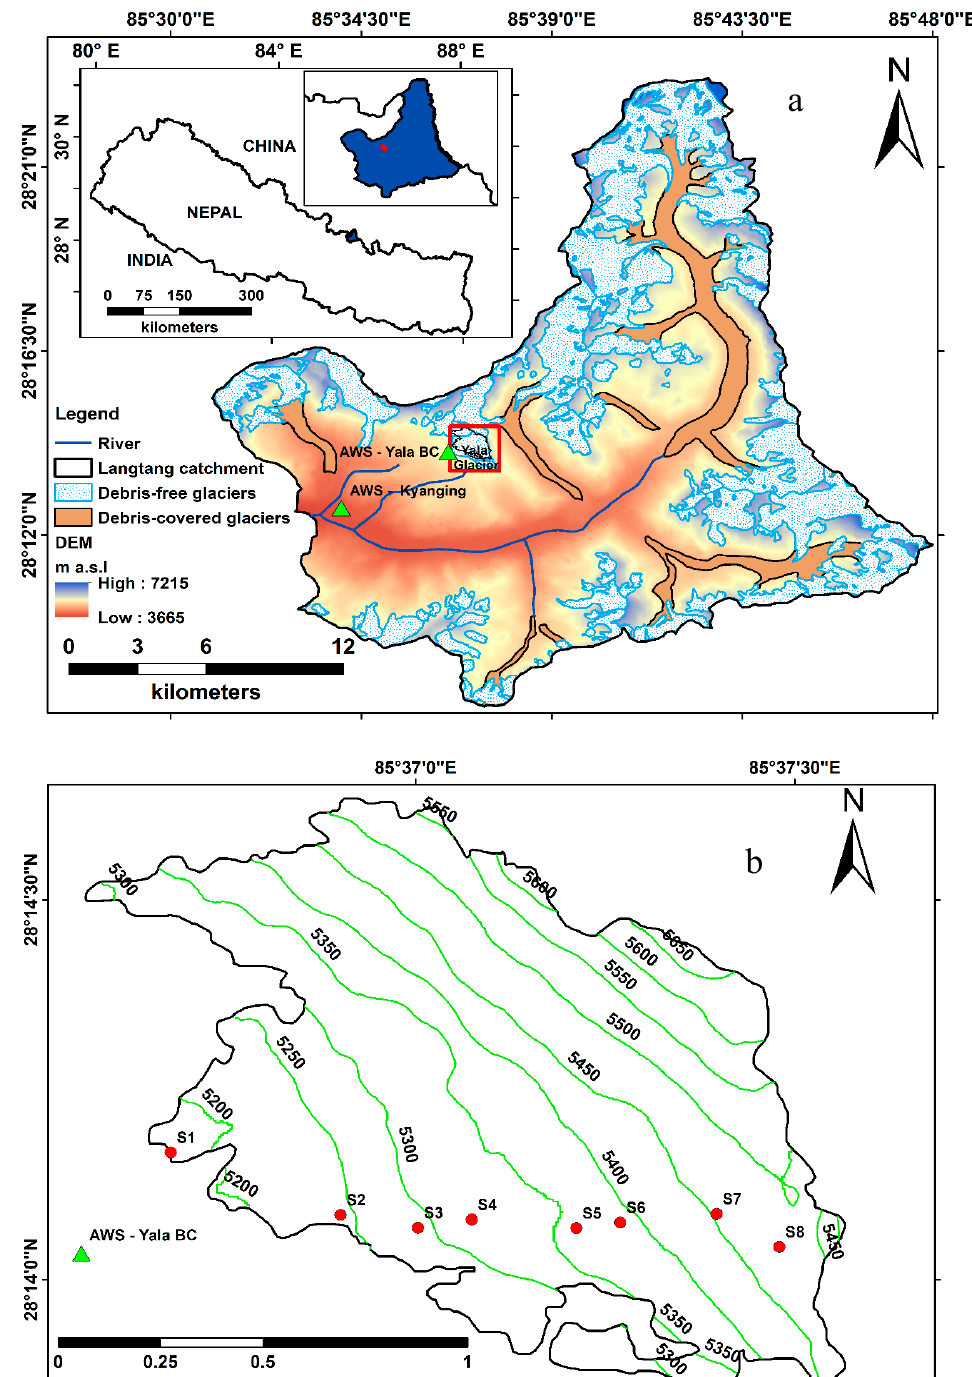
Figure 1. ( a ) Map of Langtang catchment (blue polygon) in the inset map of Nepal. Location of Yala Glacier (inside the red box), Kyangjing and Yala base camp (BC) Automatic Weather Stations (AWSs) (green triangles) in Langtang catchment. ( b ) Map of Yala Glacier showing the network of ablation stakes (red circles numbered from S1 to S8), AWS at Yala base camp (green triangle) and contour interval at 50 m altitudinal range (green